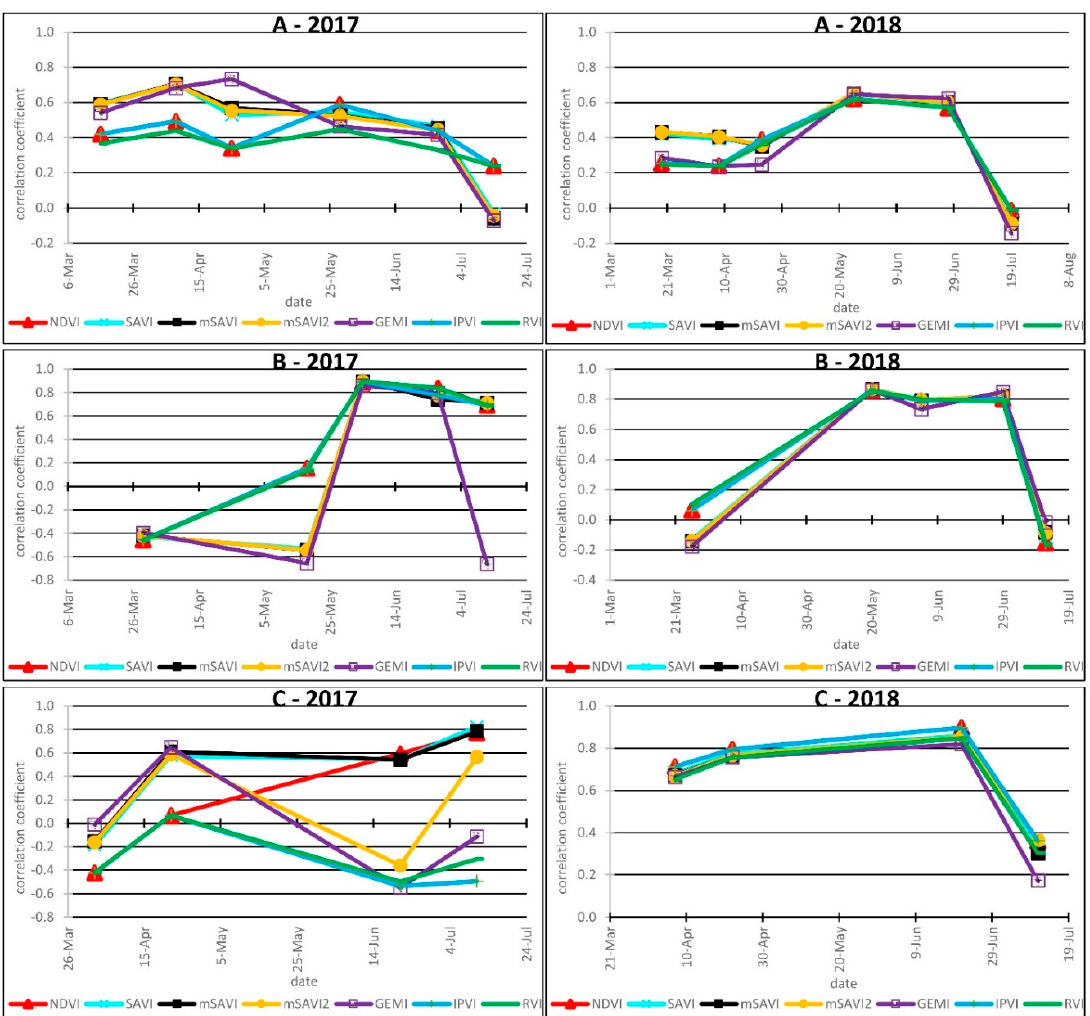
Figure 7. Values of correlation coefficients between vegetation indices and grain yield (t ∙ ha − 1 ) in three locations (A—Bro ż ówka, B—Zdziechów, C—Kry ł ów) on the selected dates in years 2017 (charts in the left side) and 2018 (charts in the right side).